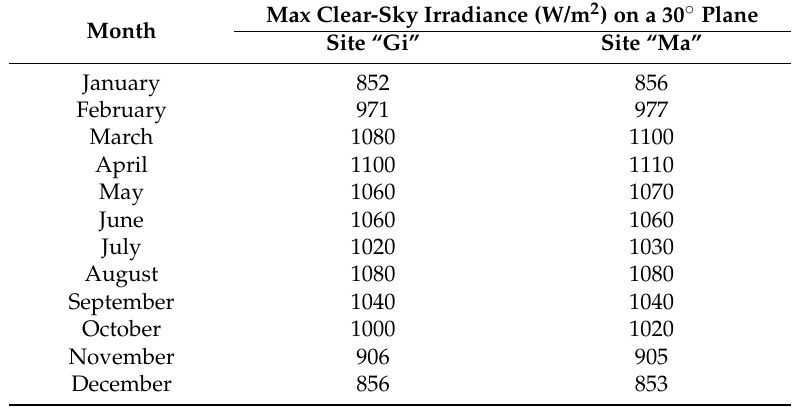
Table 4. Maximum clear-sky solar irradiance values with tilted angle of 30 ˝ for each month of